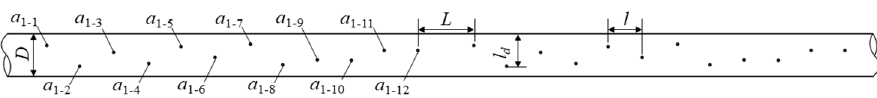
Figure 1. Sketch of orifice arrangement on a part of the micro-sprinkling hose.